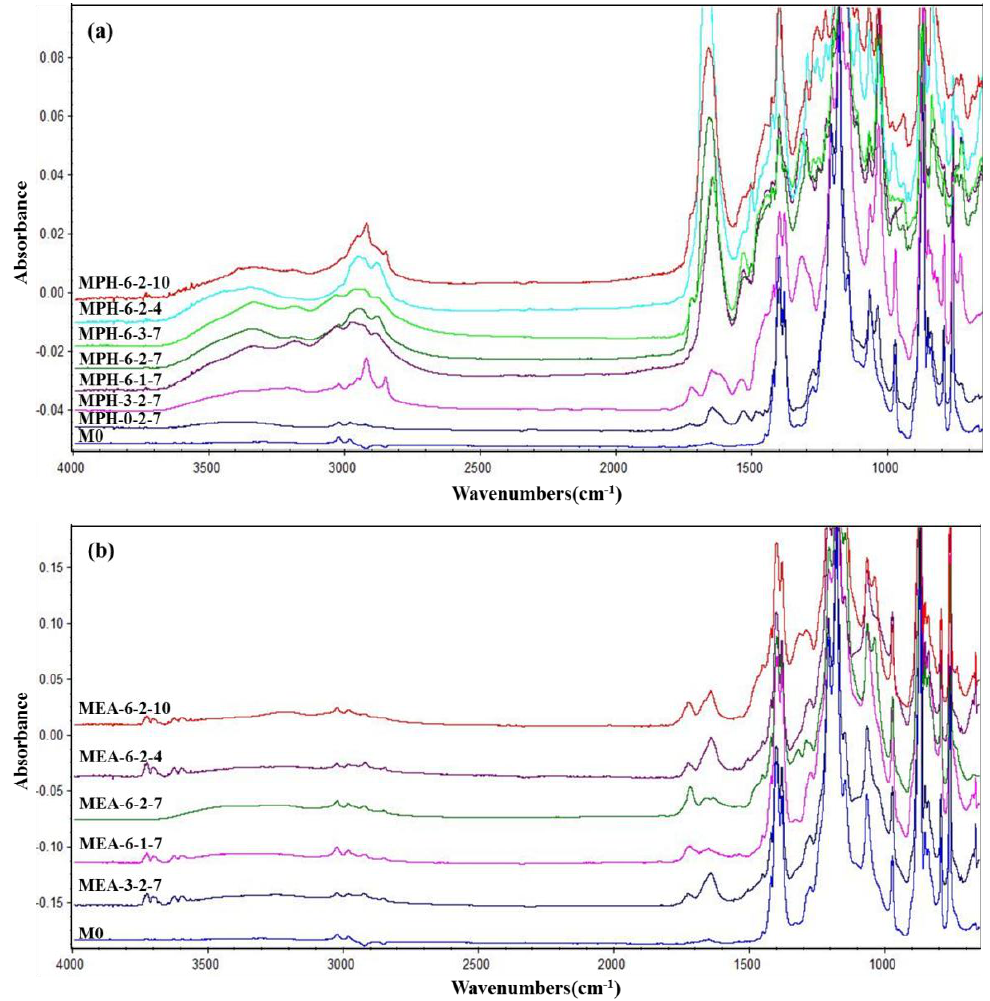
Figure 1. ATR-FTIR spectra of various membranes ( a ) polyMPDSAH-g-PVDF membrane; ( b ) polyMEDSA-g-PVDF membrane.